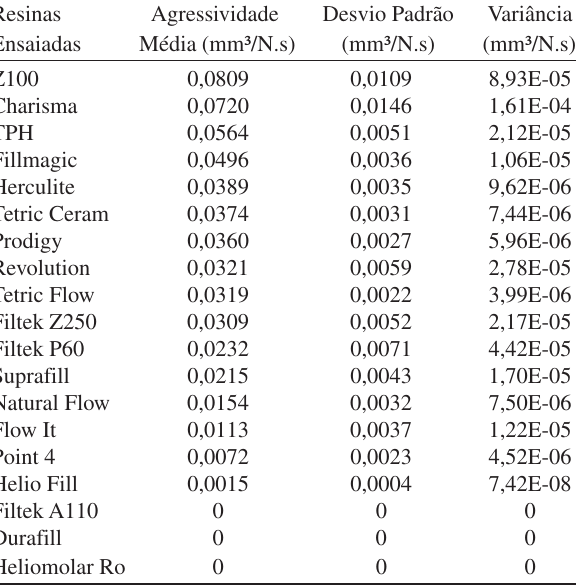
Tabela 1. Resultados obtidos nos ensaios de agressividade das